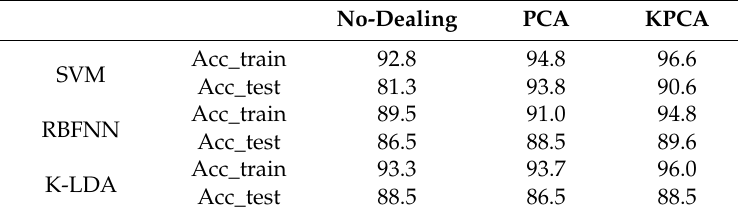
Figure 8. The classification accuracy of different values of α and β . Table 8. The results of the existing common feature extraction techniques and classifiers (%).